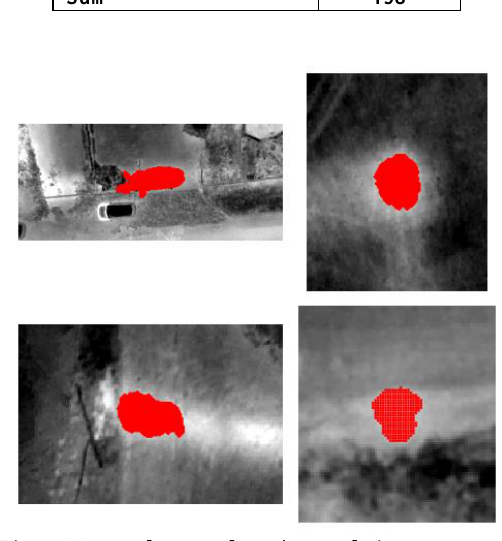
Figure 5 Anomaly examples - abnormal pipe temperature